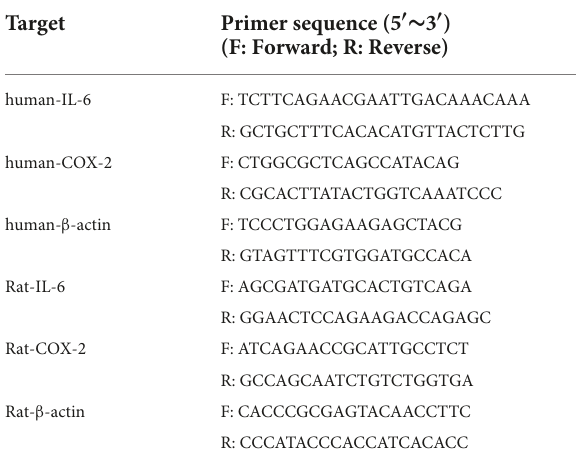
TABLE 1 Primers for